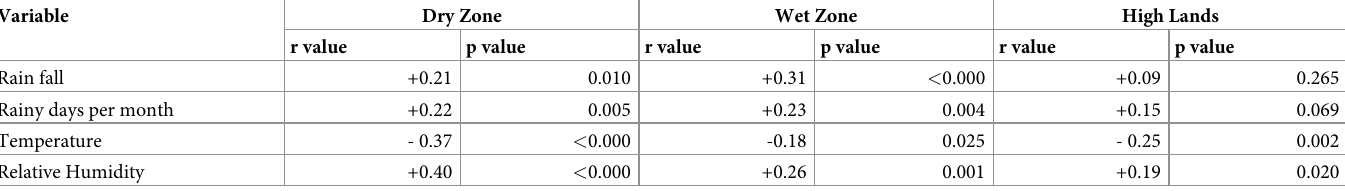
Table 5. Correlation coefficient ( r ) between the number of patients with leptospirosis and individual meteorological variables for each of the climatic zones. Variable